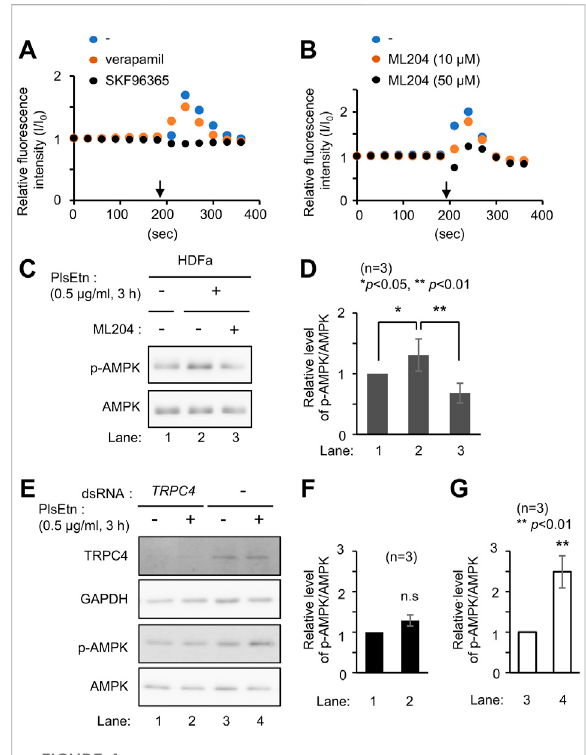
FIGURE 4 PlsEtnactivateTRPC4, leading to enhancedphosphorylation of AMPK (A) IntracellularCa 2+ concentrationofHDF-acellsloadedwith Fluo-4AMbeforeandafterPlsEtnstimulation(arrow)inthepresence of vehicle (-), verapamil, orSKF96365.Fluorescenceintensity at each time point normalized to that at time 0 was calculated and plotted (B) FluorescenceintensityofPlsEtn-stimulatedHDF-acellsin thepresenceofvehicle(-)orML204 (C) Immunoblotforp-AMPKand total AMPK in untreatedHDF-a cells (-) or cells treatedwith PlsEtn in theabsence(-)orpresence(+)ofML204(50 μ M)for7 h (D) Amount of p-AMPK to total AMPK in (C) ( n = 3) (E) Immunoblot for p-AMPK and total AMPK in PlsEtn-unstimulated (-) or -stimulated (+) HDF-a cells transfected with control dsRNA or dsRNA against TRPC4 (F,G) Amount of p-AMPK to total AMPK in (E) ( n =